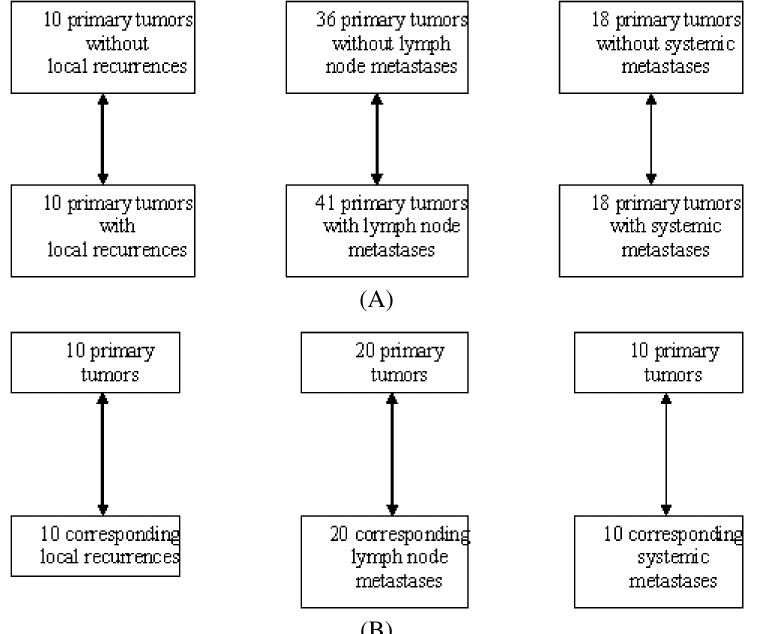
Fig. 1. Study design: (A) Comparison of primary tumors without and with secondary manifestations; (B) Comparison of primary tumors and their corresponding secondary manifestations. gene expression patterns between primary tumors and their metastases [2,3,29]. These consistent features in primary tumors and their metastases refer to the exis- tence of markers in primary tumors, which are associ- ated with the occurrence of